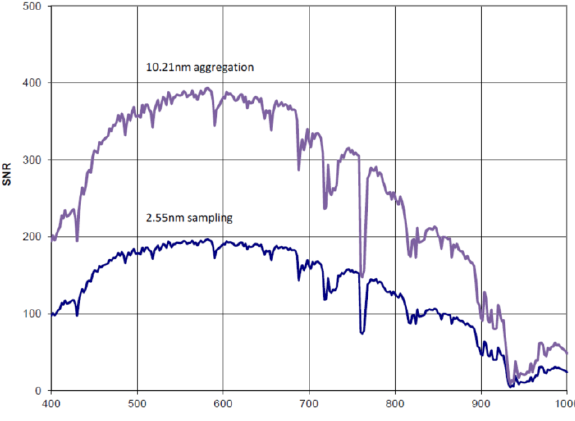
Figure 3 Signal-to-Noise Ratio (SNR) for the spectral sampling of 2.55 nm (lower curve) and the 4x binning with 10.21 nm spectral sampling (upper curve). Simulation based on Modtran with standard mid latitude summer atmosphere (Albedo: 0.3; Sampling 0.2 nm). (© DLR Optical Systems) DESIS is equipped with a POI consisting of two fixed and one rotating mirror in front of the entrance slit that allows, by rotating one mirror, a forward and backward viewing change up to ±15° w.r.t. the nominal (e.g. nadir) view. The POI can be operated in a static mode with 3° angle steps for the viewing direction and in a dynamic mode with up to 1.5° change in viewing direction per seconds. This change in viewing direction allows – besides normal Earth data takes – acquiring experimental data to produce e.g. stereo or Bidirectional Reflectance Distribution Function (BRDF) products and continuous observations of the same targets on ground (FMC forward motion compensation). The POI can be also operated in calibration mode to minimize the external light fields and allowing on-board calibration